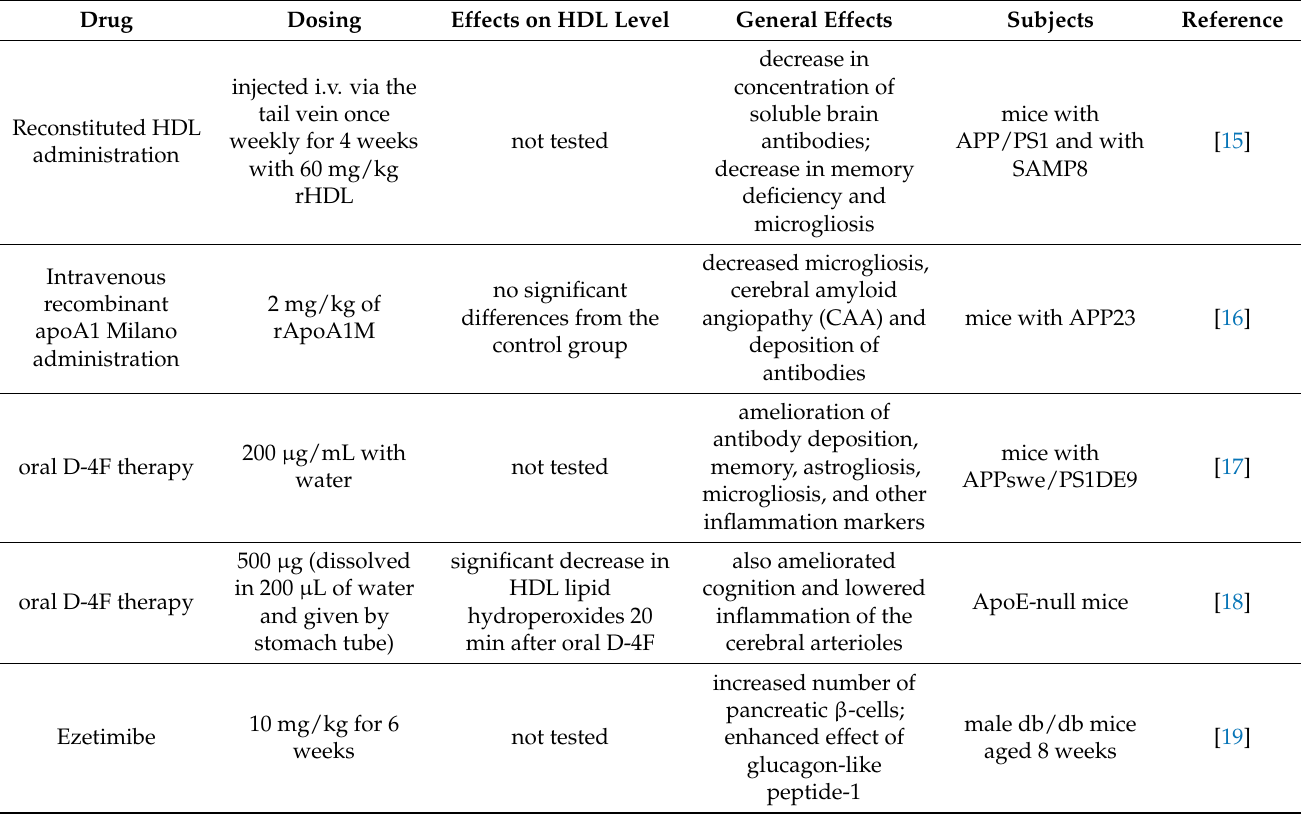
Table 1. Summary of animal studies targeting HDL in various pathologies.